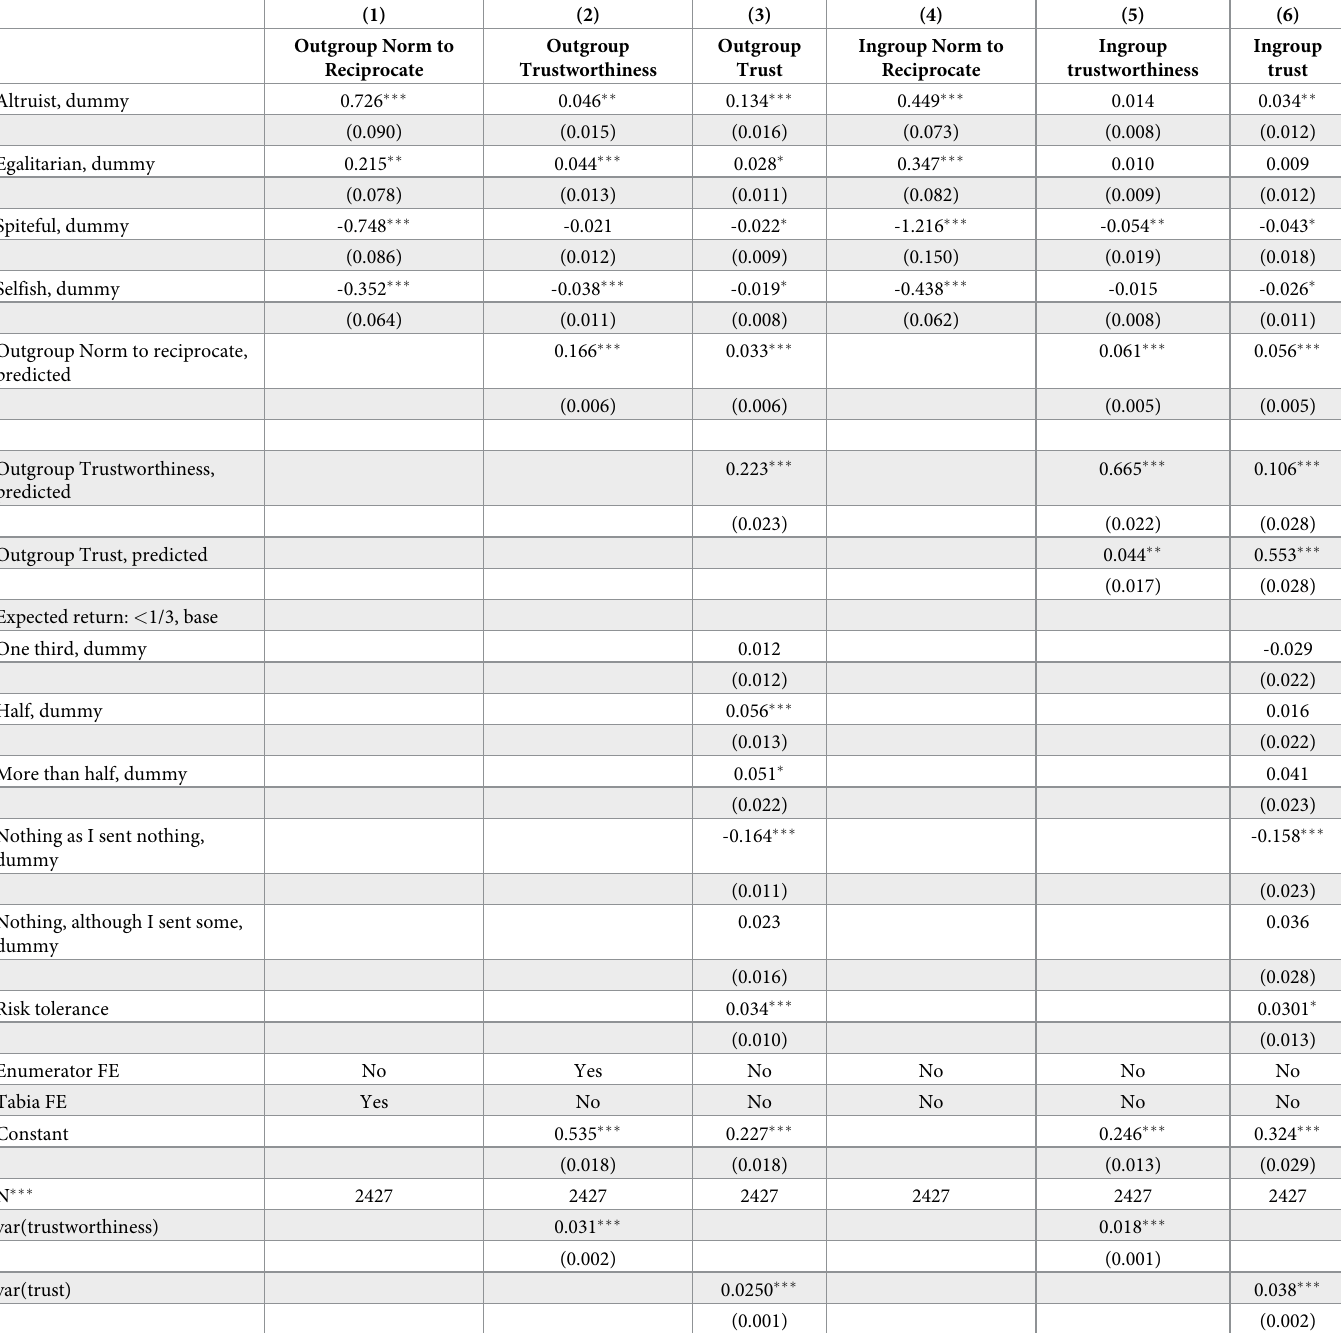
Table 6. Structural equation model: Recursive system Outgroup - > Ingroup social preferences, norms, trustworthiness, and